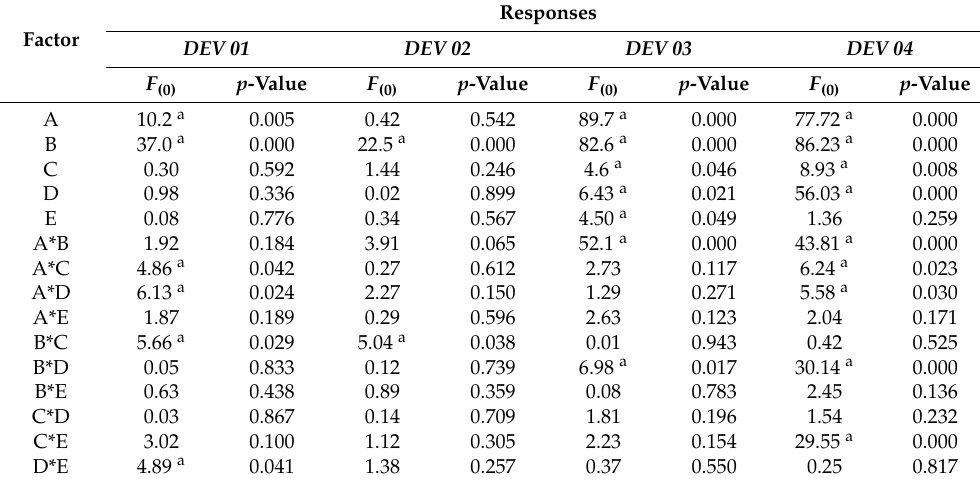
Table 3. ANOVA summary table, results for the deviation analysis vs. factors in main experiments.